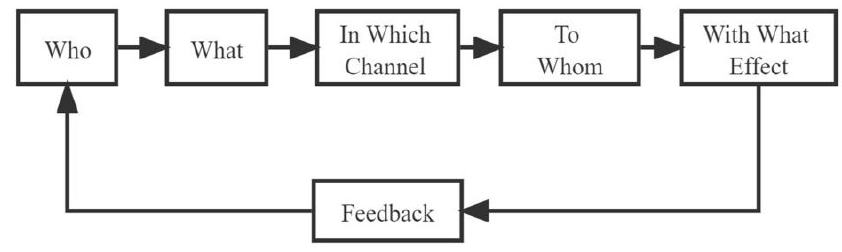
Figure 3. “5W” communication model that was proposed by Harold Lasswell.